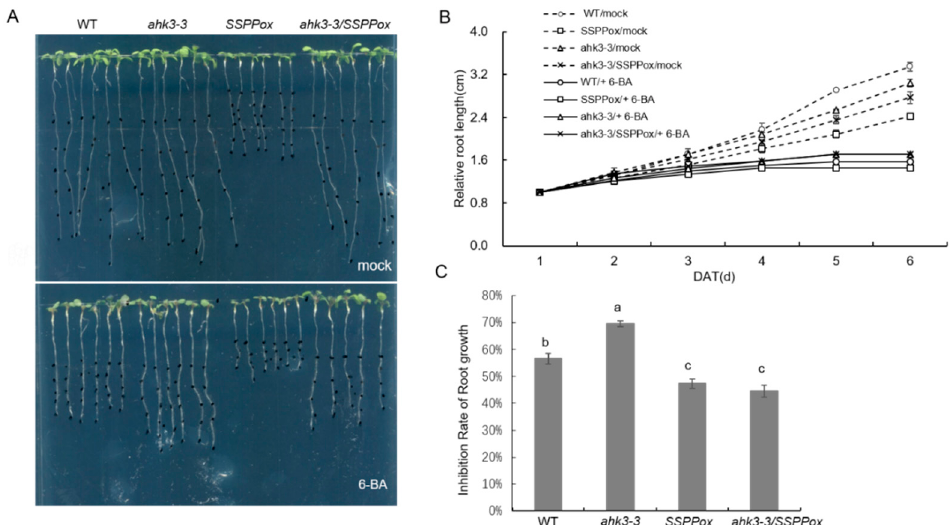
Figure 3. Loss of AHK3 diminished the hypersensitivity of SSPP -overexpressing Arabidopsis to exogenous cytokinin treatment. ( A ) Four-day-old WT, ahk3-3 , SSPPox , and ahk3-3/SSPPox transgenic seedlings were grown on vertical plates containing either 6 μ M 6-BA or a mock solution for additional 6 days and photographed. ( B ) Comparison of relative root length of WT, ahk3-3, SSPPox , and ahk3- 3/SSPPox transgenic seedlings under either mock or 6-BA treatment every day for a total period of six days. ( C ) Comparison of growth inhibition rates of main root growth of WT, ahk3-3, SSPPox , and ahk3- 3/SSPPox at 6 days after treatment (DAT) . Data shown are the typical results of three biological replicates. Different letters indicate statistically significant differences based on analysis of variance (ANOVA) ( α = 0.05). Error bars represent SE.